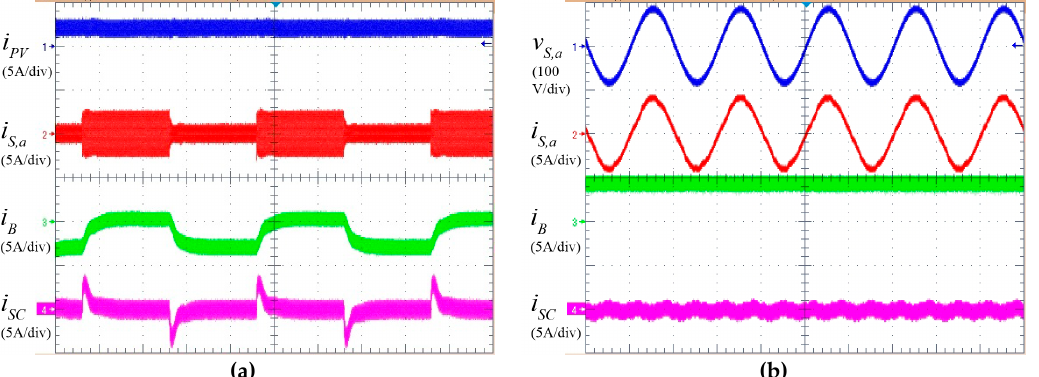
Figure 11. Experimental results. ( a ) PV current, grid current, battery and supercapacitor current for a cyclic injected power reference operation. ( b ) Grid voltage, grid current, battery and supercapacitor current for steady state operation.